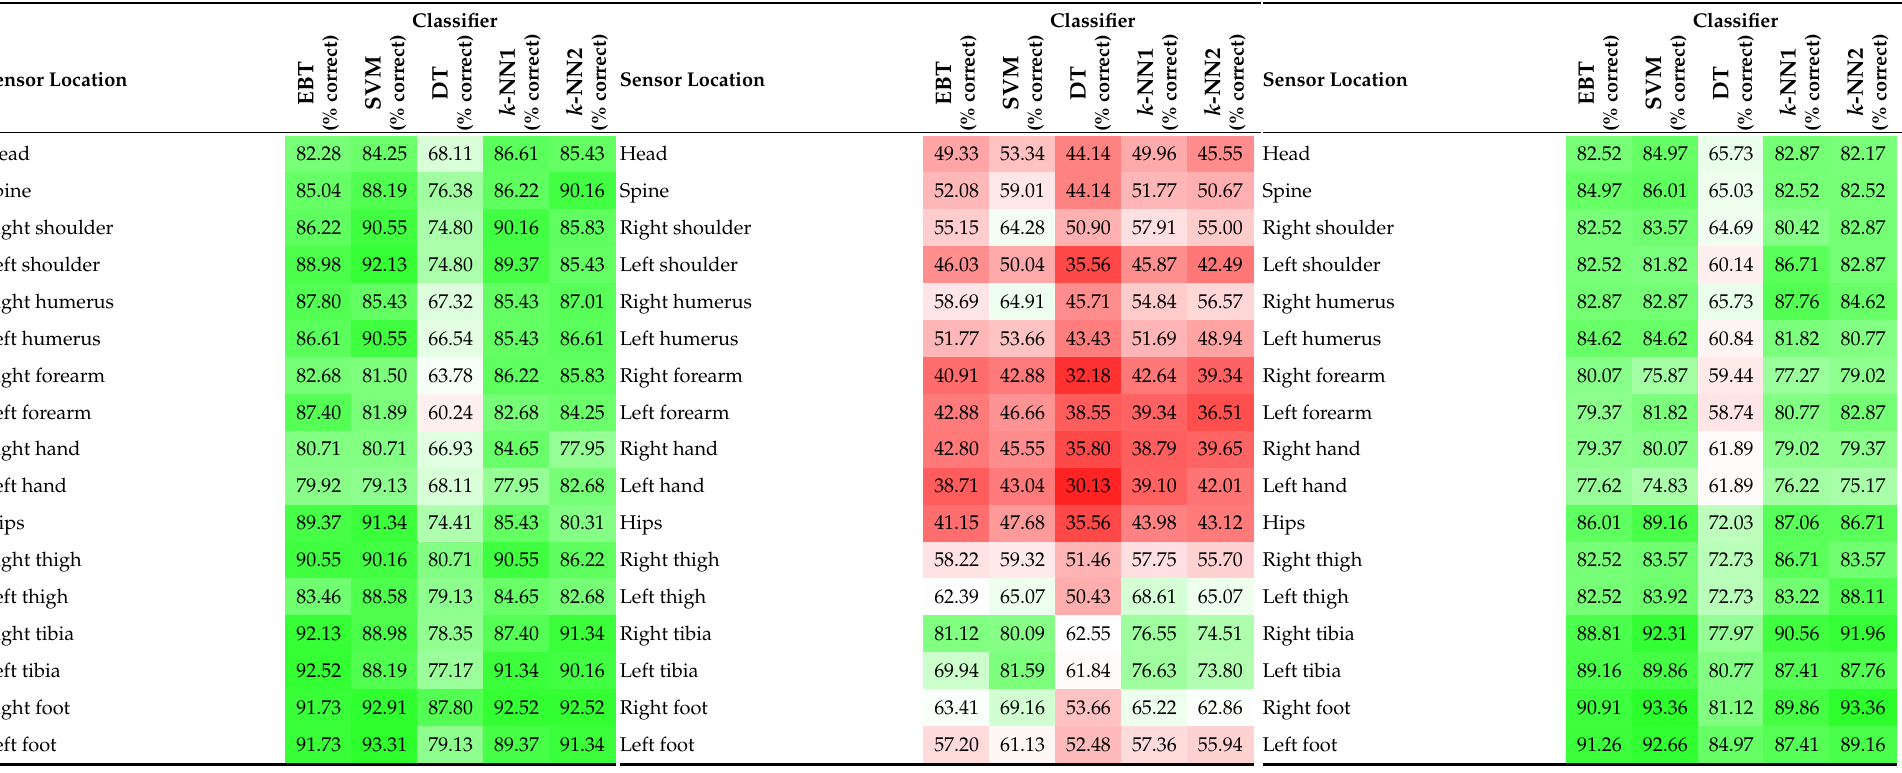
Table 8. Mean percentage of correctly classified instances for each classification algorithm. ( a ) Model trained and tested with unequipped state data; ( b ) model trained with unequipped state data, tested with equipped state data; ( c ) model trained and tested with equipped state